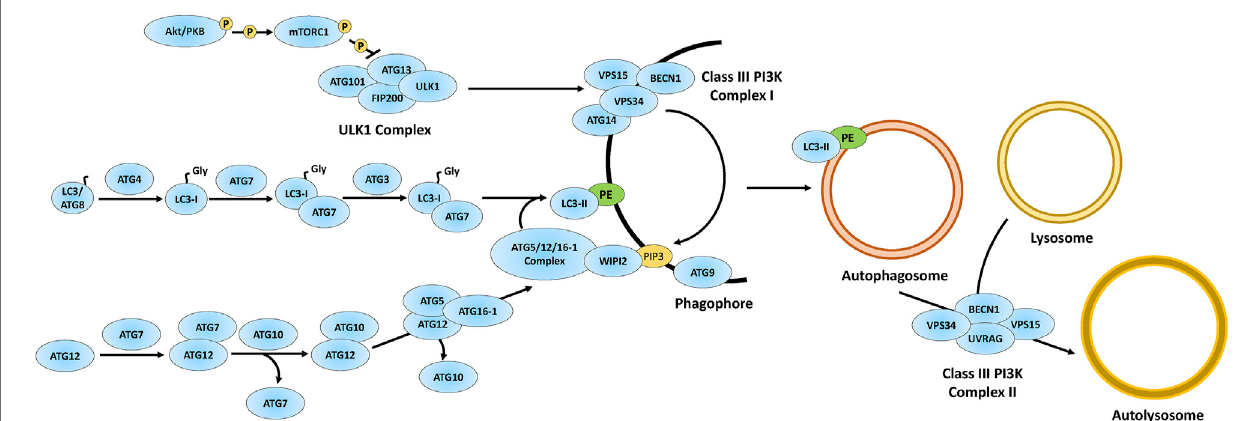
FIGURE 1 | Overview of the autophagy pathway. The autophagy proteins are involved in the formation of autophagosomes via phagophore maturation including the ULK1 complex acting on the Class III PI3K complex I to generate PIP3. The autophagy proteins also process LC3 into LC3-I, which matures into LC3-II via attachment to PE on the phagophore. Through phagophore closure, an autophagosome is formed and further matured via autophagosome-lysosomal fusion through theClassIIIPI3KcomplexII.Figureconceptwasadapted fromBentoCF.etal.(2016).Akt/PKB, proteinkinaseB;ATG3,ubiquitin-like-conjugating enzymeATG3; ATG4, cysteine protease ATG4; ATG5, autophagy protein 5; ATG7, ubiquitin-like modi fi er-activating enzyme ATG7; ATG9, autophagy protein 9; ATG10, ubiquitin-like- conjugating enzyme ATG10; ATG12, ubiquitin-like protein ATG12; ATG13, autophagy-related protein 13; ATG14, BECN1-associated autophagy-related key regulator; ATG16-1, autophagy-related protein 16-1; ATG101, autophagy-related protein 101; BECN1, beclin-1; FIP200, focal adhesion kinase family interacting protein of 200 kDa; LC3/ATG8, microtubule-associated protein 1A/1B-light chain 3/autophagy-related gene 8; PE, phosphatidylethanolamine; PIP3, phosphatidylinositol-3,4,5- triphosphate; VPS15, vacuolar protein sorting 15; VPS34, vacuolar protein sorting 34; ULK1, UNC51-like autophagy activating kinase 1; UVRAG, UV radiation resistance-associated gene; WIPI2, WD repeat domain phosphoinositide-interacting protein